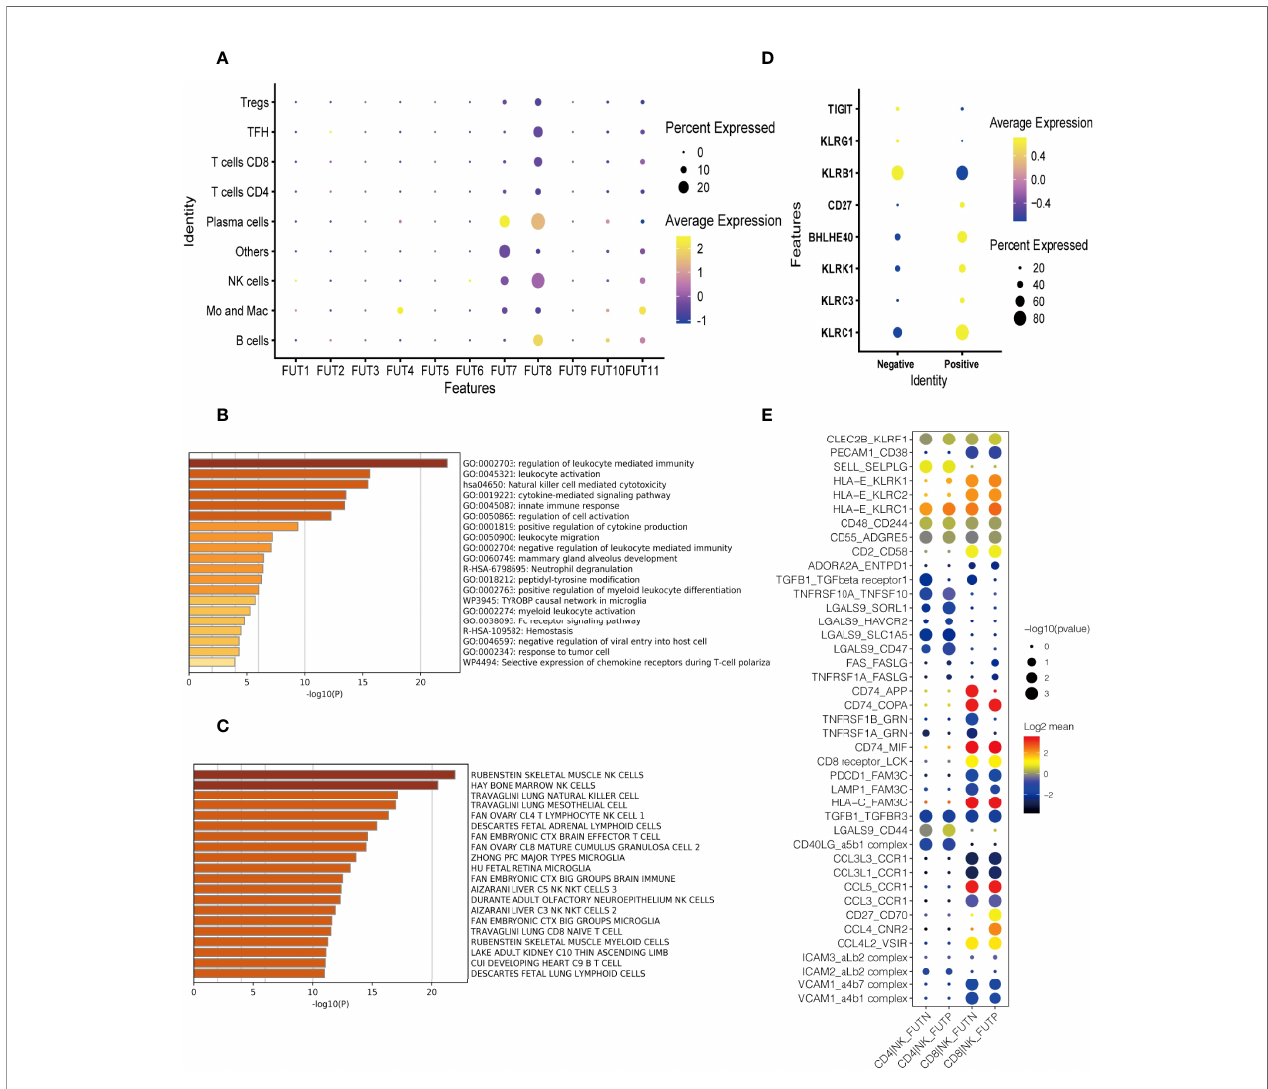
FIGURE 1 | Fucosylation promoted effector functions of NK cells in B cell lymphoma. (A) Heatmap of relative expressions of different fucosyltransferases in each cluster de fi ned by scRNA-seq analysis. The dot size represented the relative percentage of expressions. The color scale represented the expression level. (B) GSEA of the upregulated gene set in fucosylated NK cells versus normal NK cells. (C) Enrichment of cell type signatures in fucosylated NK cells versus normal NK cells. (D) Heatmap of relative expressions of NK effector genes. The dot size represented the relative percentage of expressions. The color scale represented the expression level. (E) The GO annotation of ligand-receptor pairs between NK cells and T cells. The dot size represented the adjusted p -value. The color scale represented number of